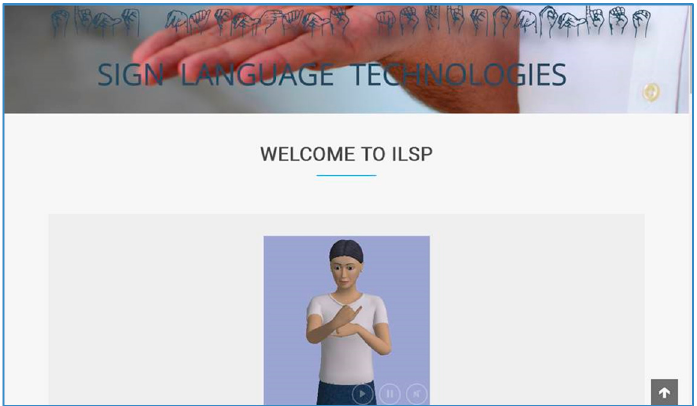
Figure 2. Welcome page message performed with synthetic signing combining multimodal expression features.